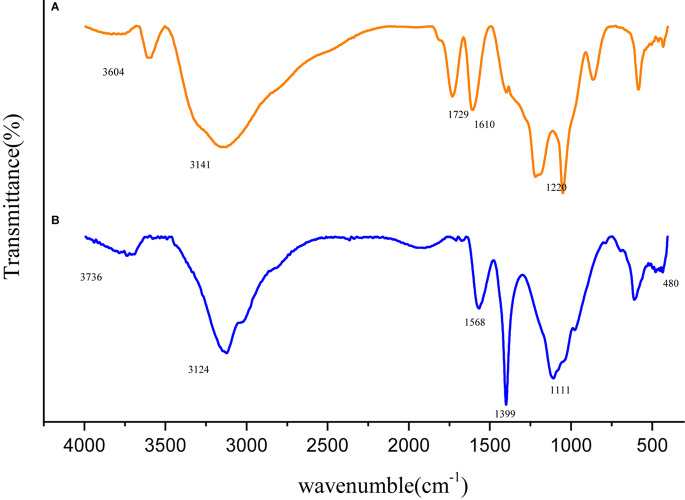
Infrared spectra of GO (A) and Fe3O4@GO (B).